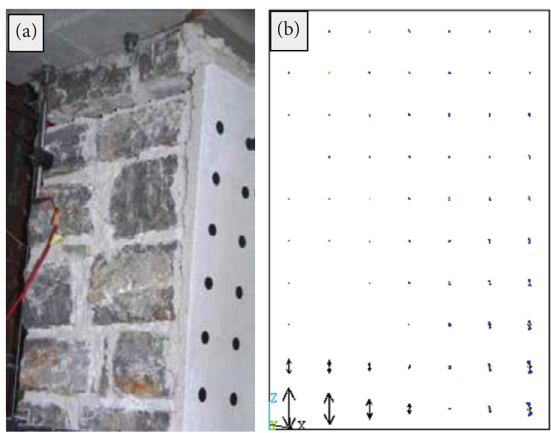
Figure 4: (a) Crack pattern on wall SNk-7.5-1, side view [18] and (b) strain plot from analysis (strain shown by